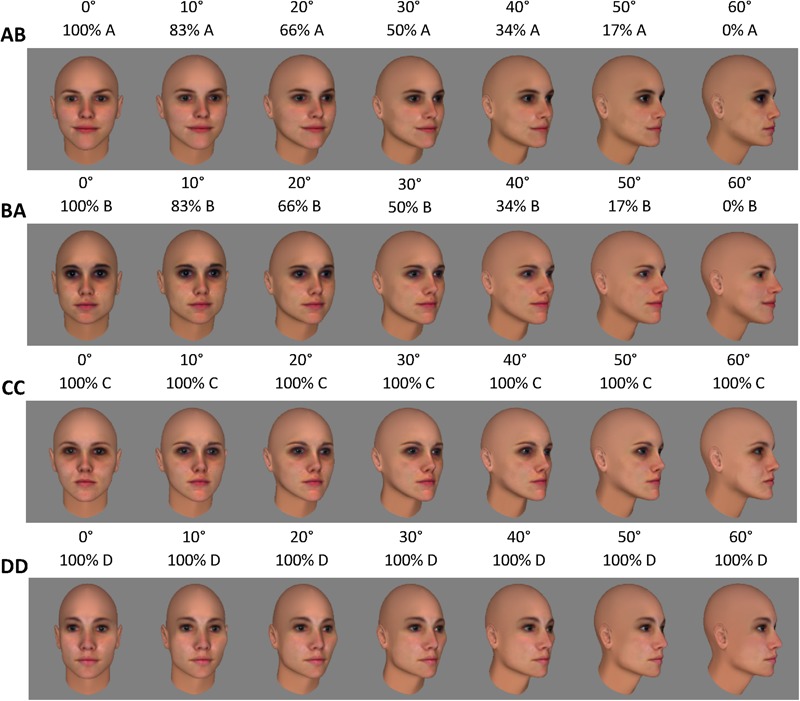
During training, 12 different face sequences (two sequences per pair) were shown. The six experimental face pairs were divided into the morph and non-morph condition. Assignment to both conditions was counterbalanced across participants. This figure presents the sequences for one pair per condition, assuming that pair AB is in the morph condition, and CD is in the non-morph condition. In morph sequences (AB and BA in this figure) the face morphed into the other face of the pair during rotation. In non-morph sequences (CC and DD) faces underwent veridical changes in appearance across the rotation.